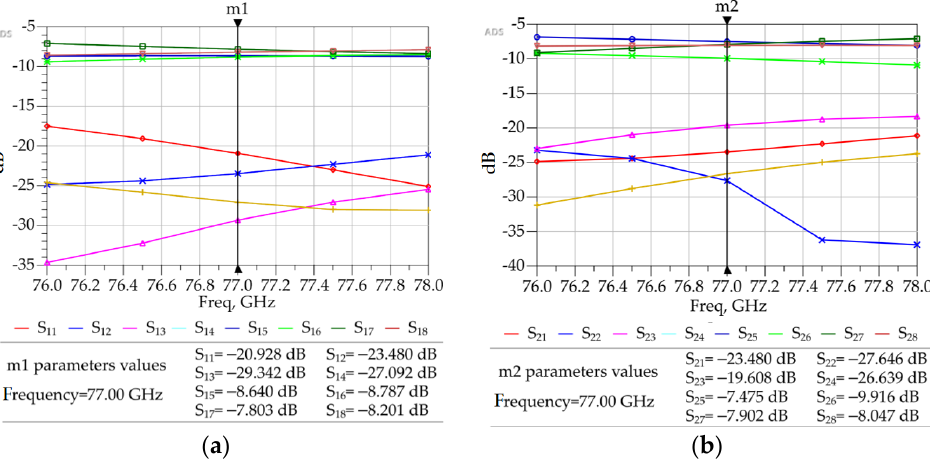
Figure 15. ADS generated 3D FEM simulation results for the 4 × 4 Butler matrix. ( a ) Isolation, return loss, and insertion losses with port P1 or P4 excited. ( b ) Isolation, return loss, and insertion losses with port P2 or P3 excited.